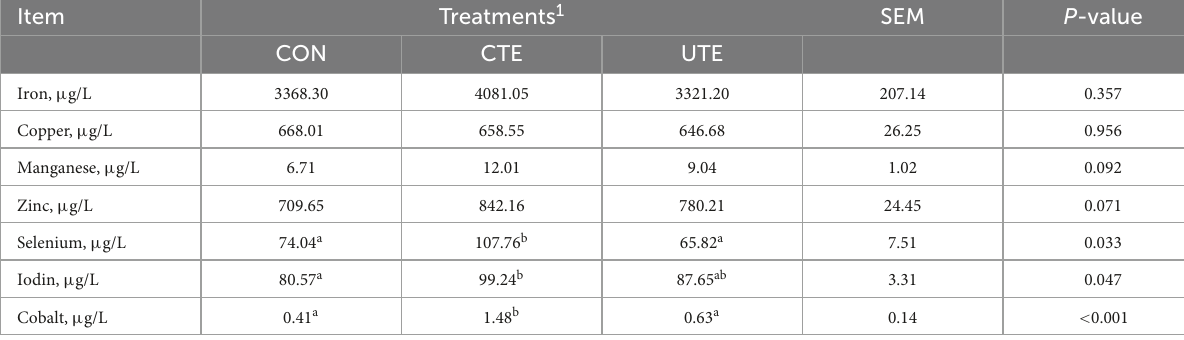
TABLE 5 Effects of coated and uncoated trace elements on serum content of trace element.